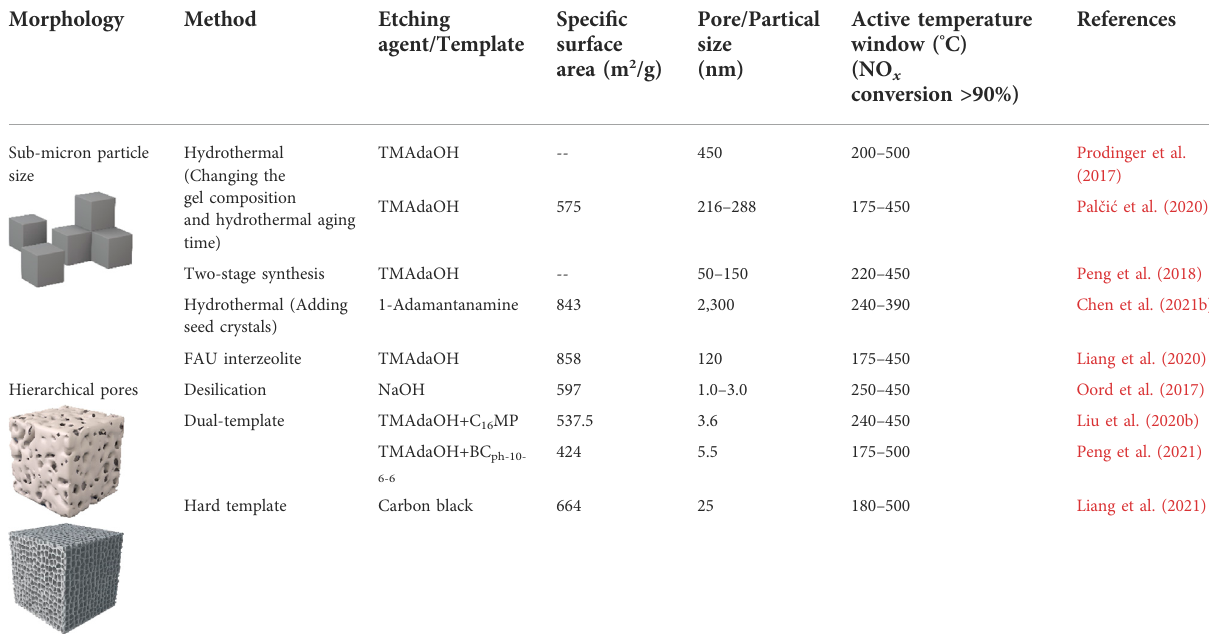
TABLE 5 Typical Cu-SSZ-13 catalysts with different morphologies reported in the literatures.